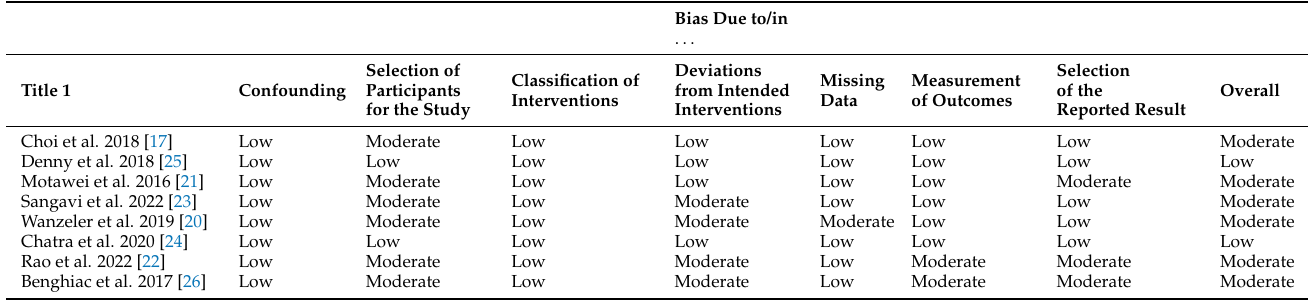
Table 2. Risk of bias of included non-randomized studies according to ROBINS-I tool [19]. Bias Due to/in